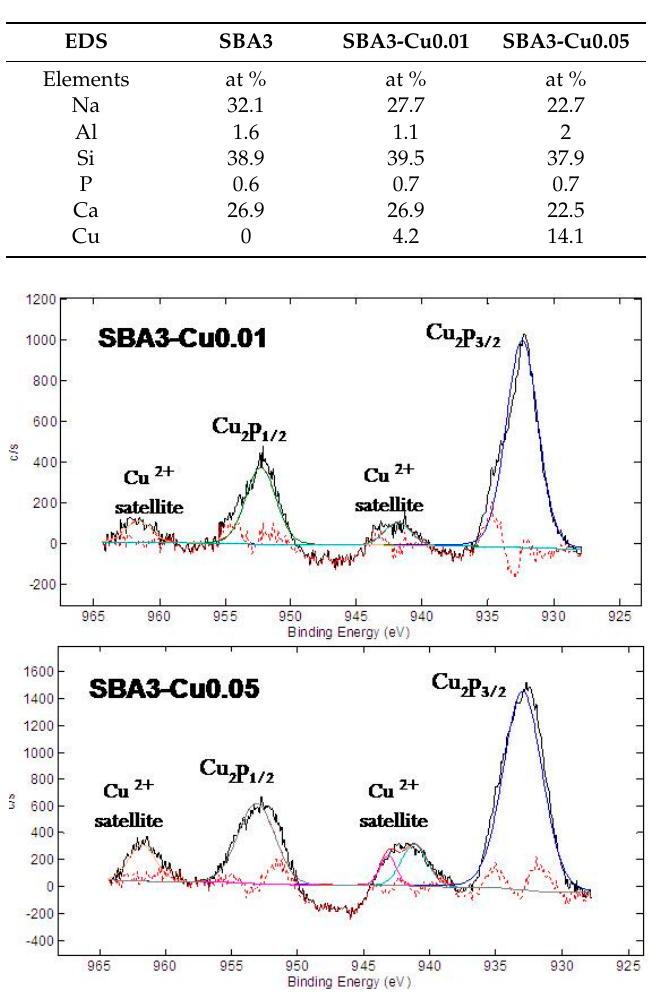
Figure 8. XPS detailed analyses of Cu 2p region of SBA3-Cu0.01 and SBA3-Cu0.05.